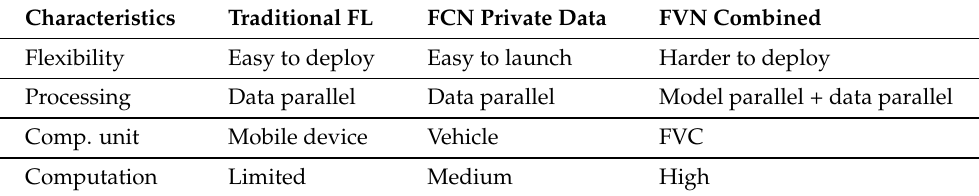
Table 2. Evaluation of FL paradigms in the VANET environment.